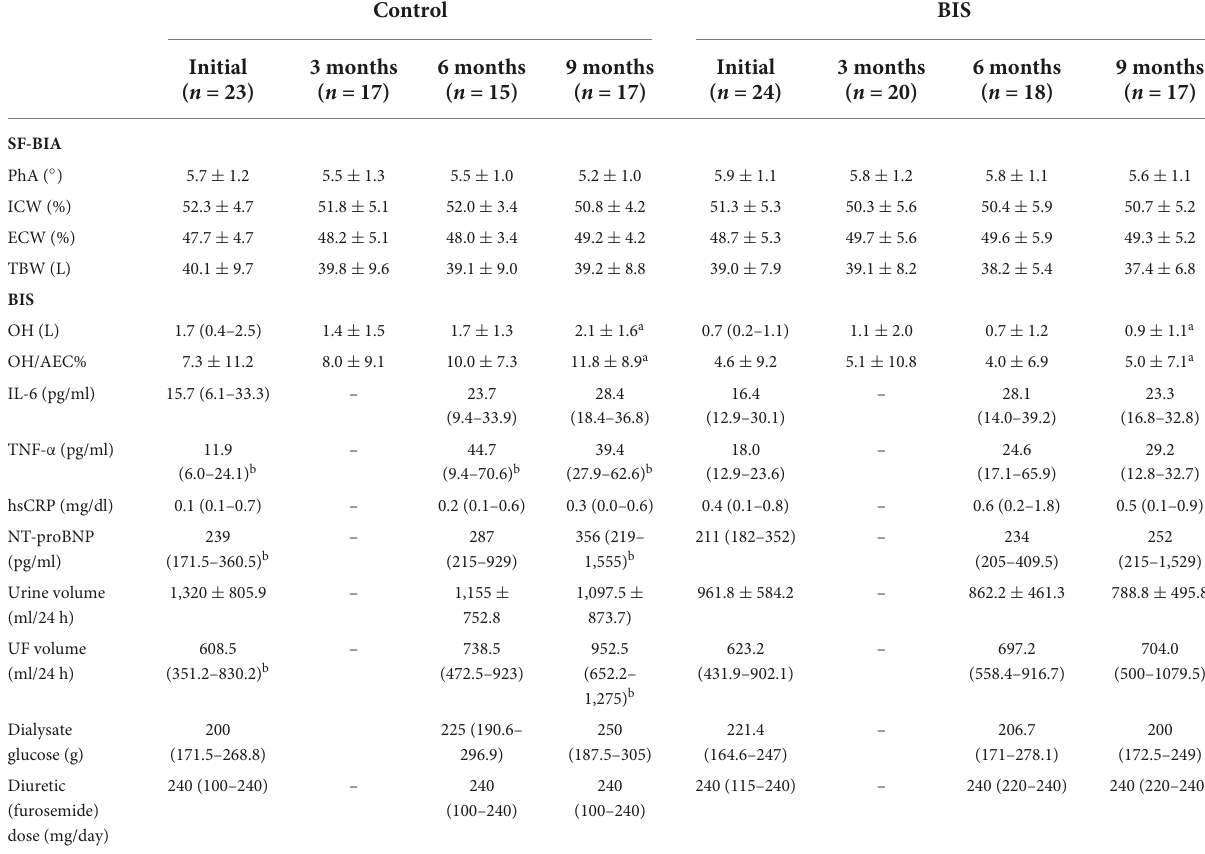
TABLE 3 Evolution of hydration measurements by BIA, inflammatory markers, NT-proBNP, residual urine volume, UF volume, dialysate glucose, and diuretic dose in the evaluation moments between the different groups.